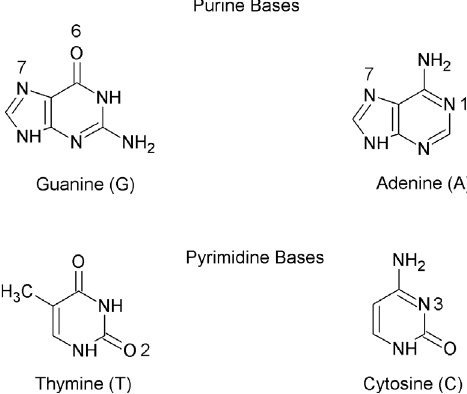
Figure 1 Structures of the purine bases guanine (G) and adenine (A) and the pyrimidine bases thymine (T) and cytosine (C). The N and O atoms that generally coordinate with metal ions are